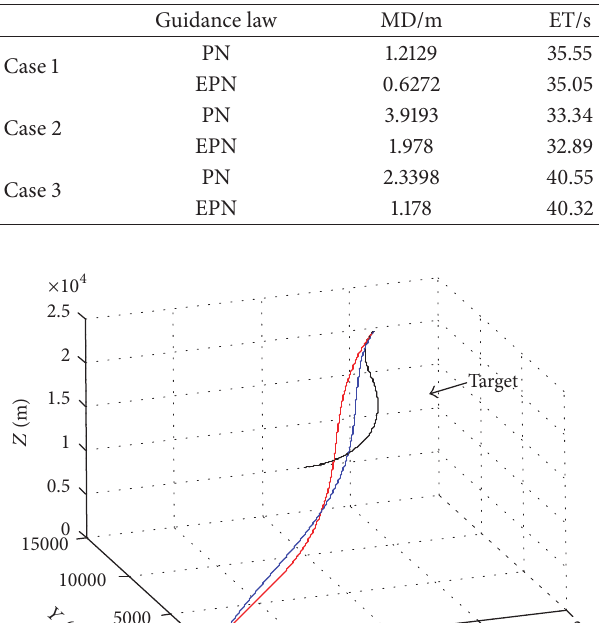
Table 1: Engagement specifications. Table 2: Comparison of the interception performance.